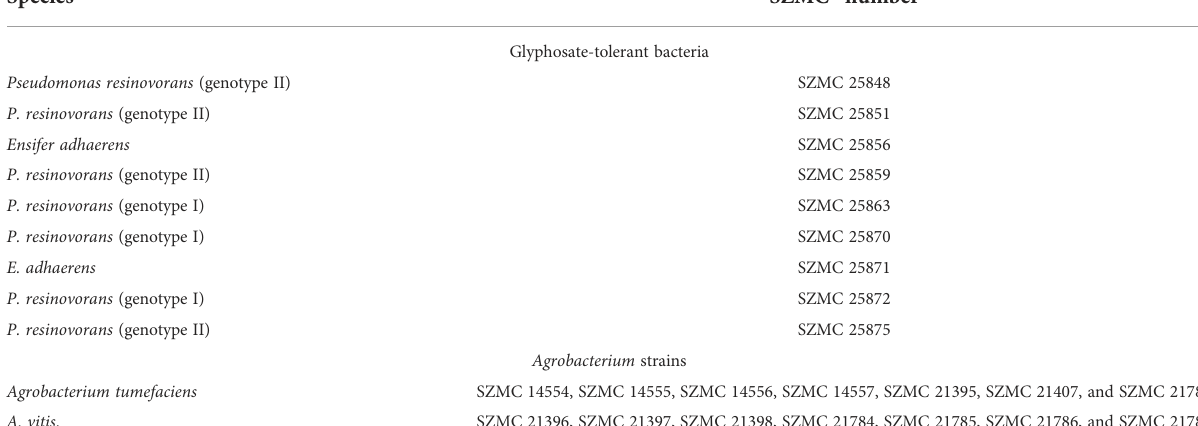
TABLE 1 List of the studied glyphosate-tolerant isolates and Agrobacterium strains.